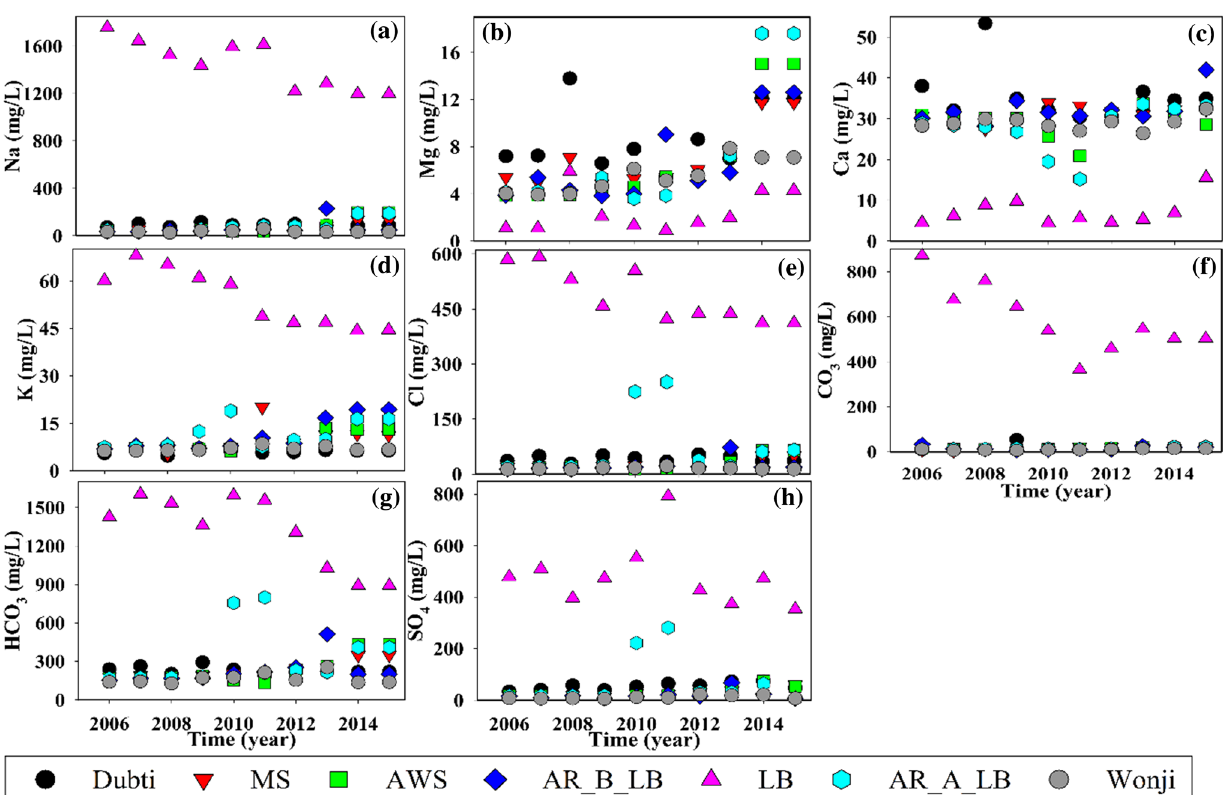
Fig. 5 Spatiotemporal variabilities of the concentrations of major ions in the Awash River and Lake